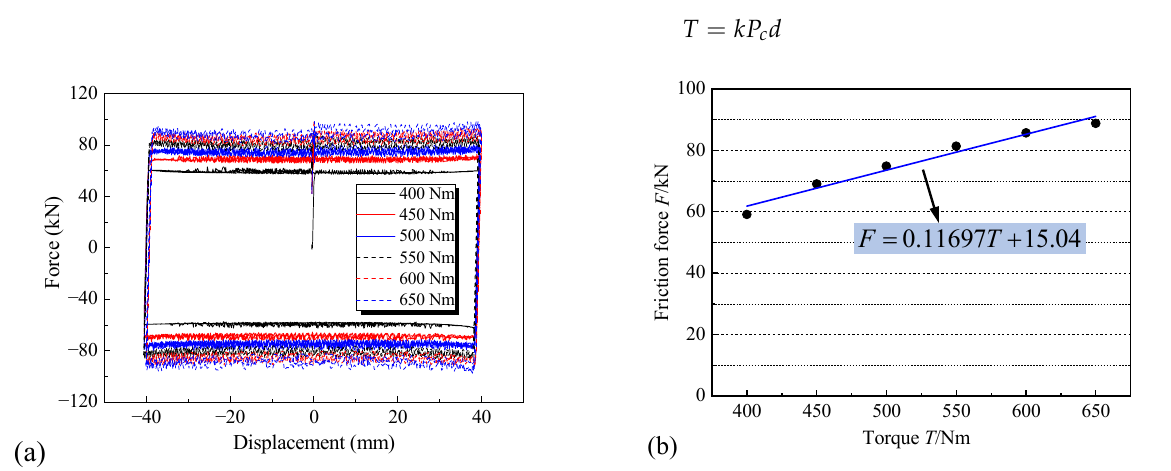
Figure 7. Experiment results: ( a ) hysteresis loop; and ( b ) relationship between the torque and fric ‐ tion force.